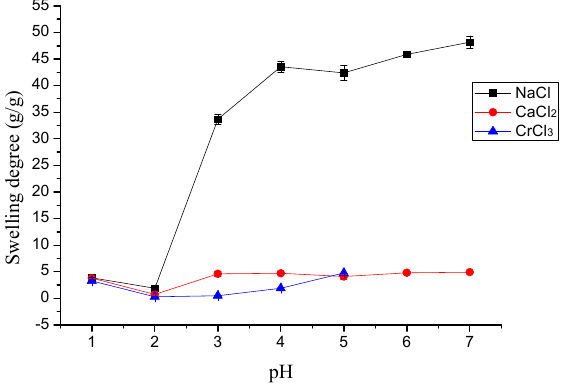
Figure 3. The effect of pH on the swelling study of metal ions.